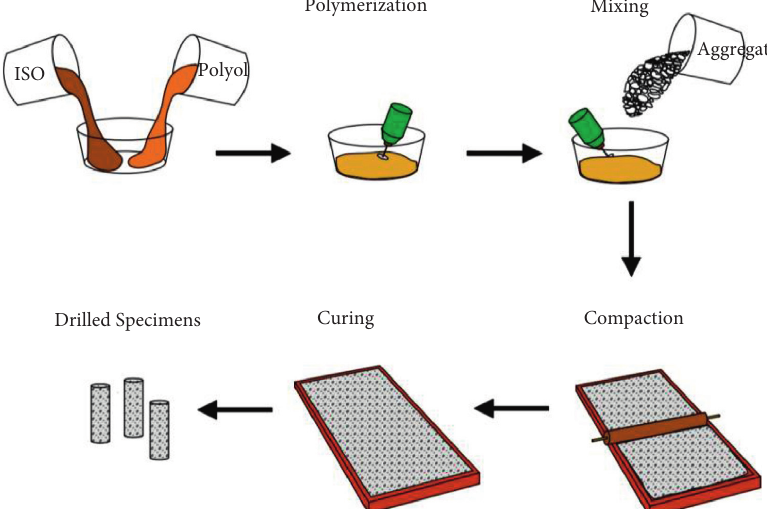
Figure 2: Manufacturing process of the PUPM specimens.